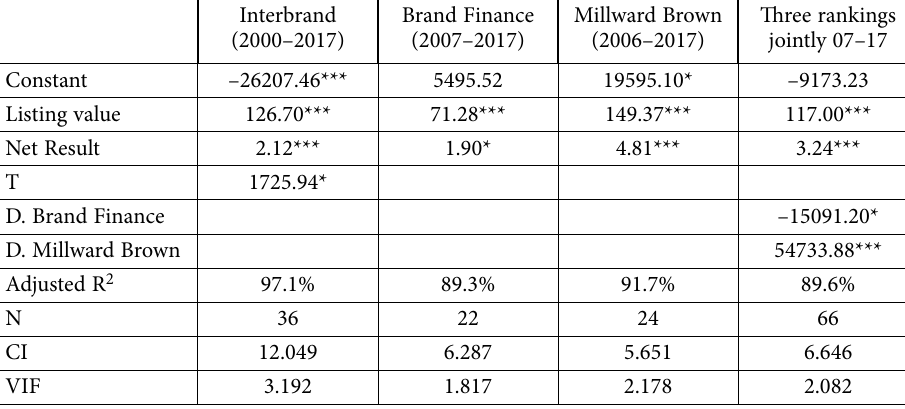
Table 8. The linear regression results for the high-value brands of the Internet, content & information industry